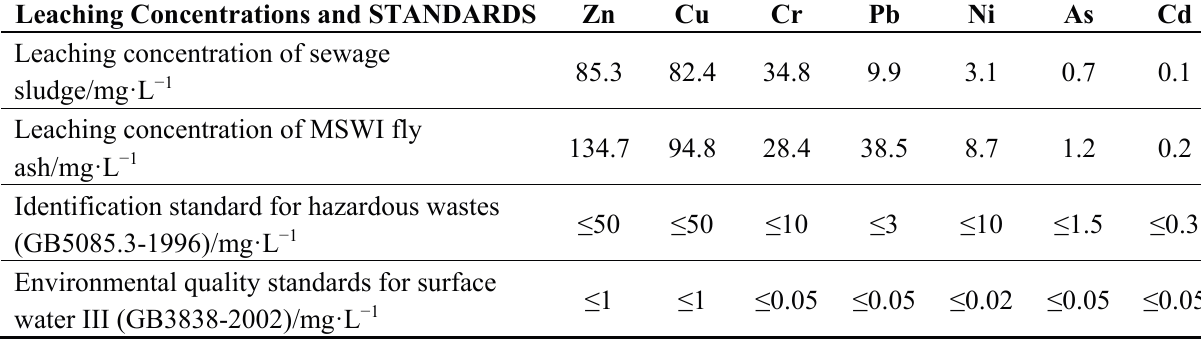
Table 3. Heavy metal concentrations and leaching test results of the